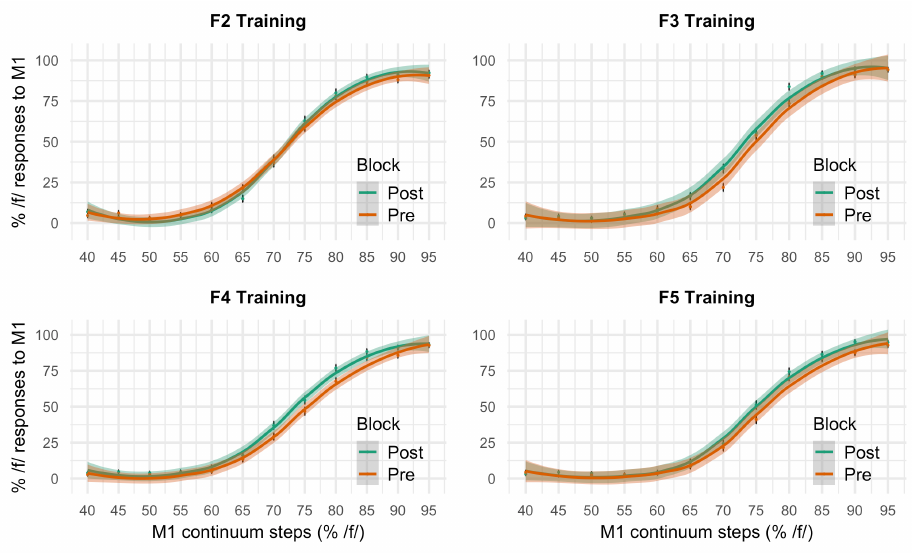
Figure 1: Pre-test and post-test classi(cid:976)ication for M1 continuum (F2-F5